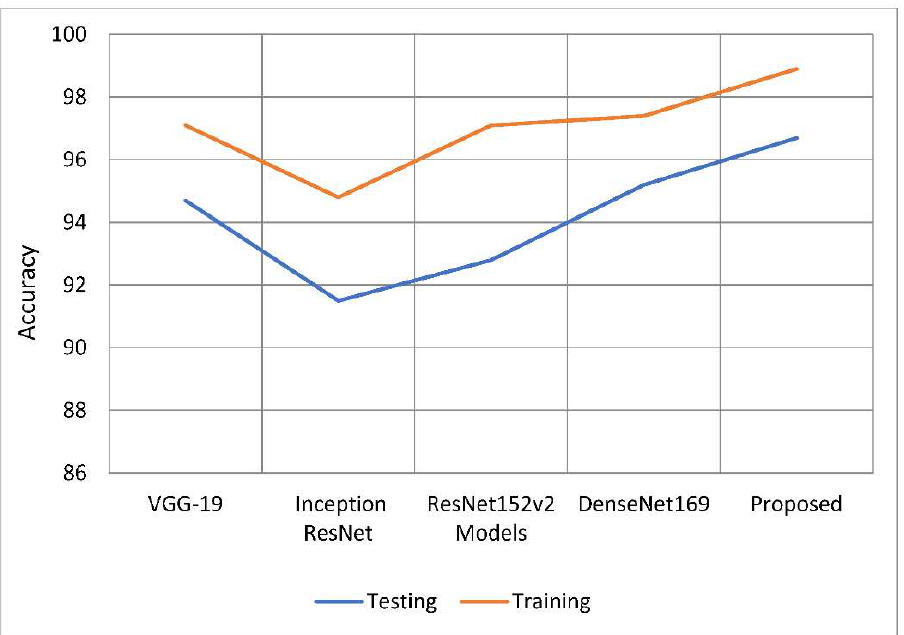
Table 4. Comparison of the testing and training accuracy of the proposed model with traditional models.